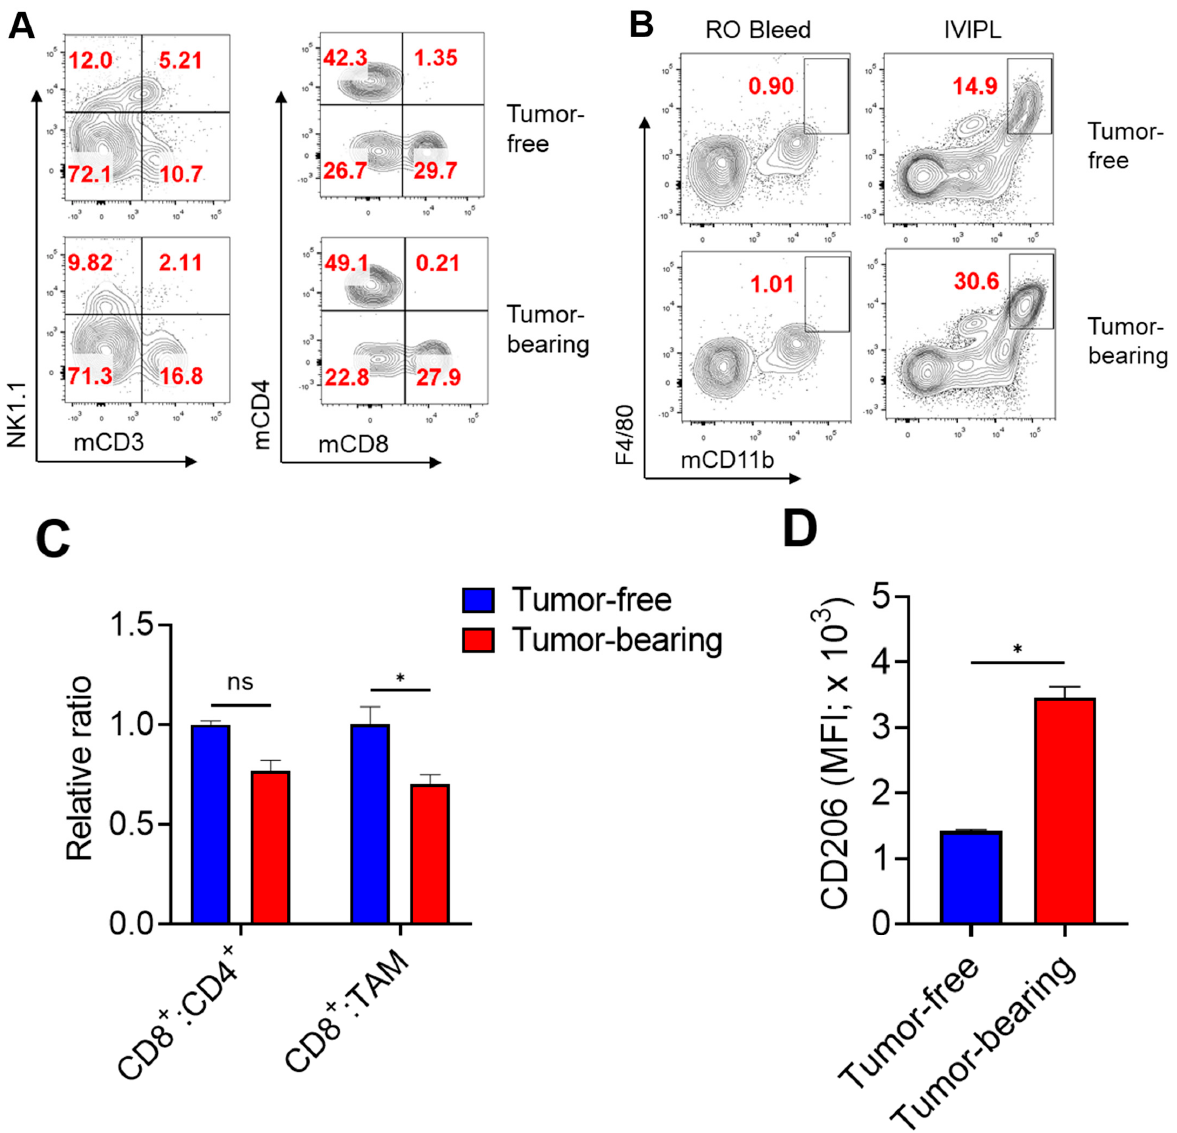
Figure 2. IVIPL can provide real-time insights into tumorigenesis in a syngeneic model. ( A – C ) B6 mice injected i.p. with 5 × 10 6 ID8 cancer cells or PBS were assessed for peritoneal cavity and peripheral blood cell compositions 20 days later using IVIPL and RO bleeds, respectively (n = 2 per group). ( A ) FACS plots showing the presence of lymphocytes, left plots gated on mCD45 + cells, right plots gated on mCD45 + mCD3 + NK1.1 - ( B ) Representative FACS showing the presence of macrophages in peripheral blood and the peritoneal cavity in tumor-free and tumor-bearing mice. ( C ) Summary data of CD8 + :CD4 + T cell ratios and CD8 + :TAM ratios relative to the ratios in tumor-free mice. ( D ) Summary of MFI of CD206 on IVIPL isolated mCD45 + mCD11b + F4/80 + cells. ns, not significant; * p < 0.05.